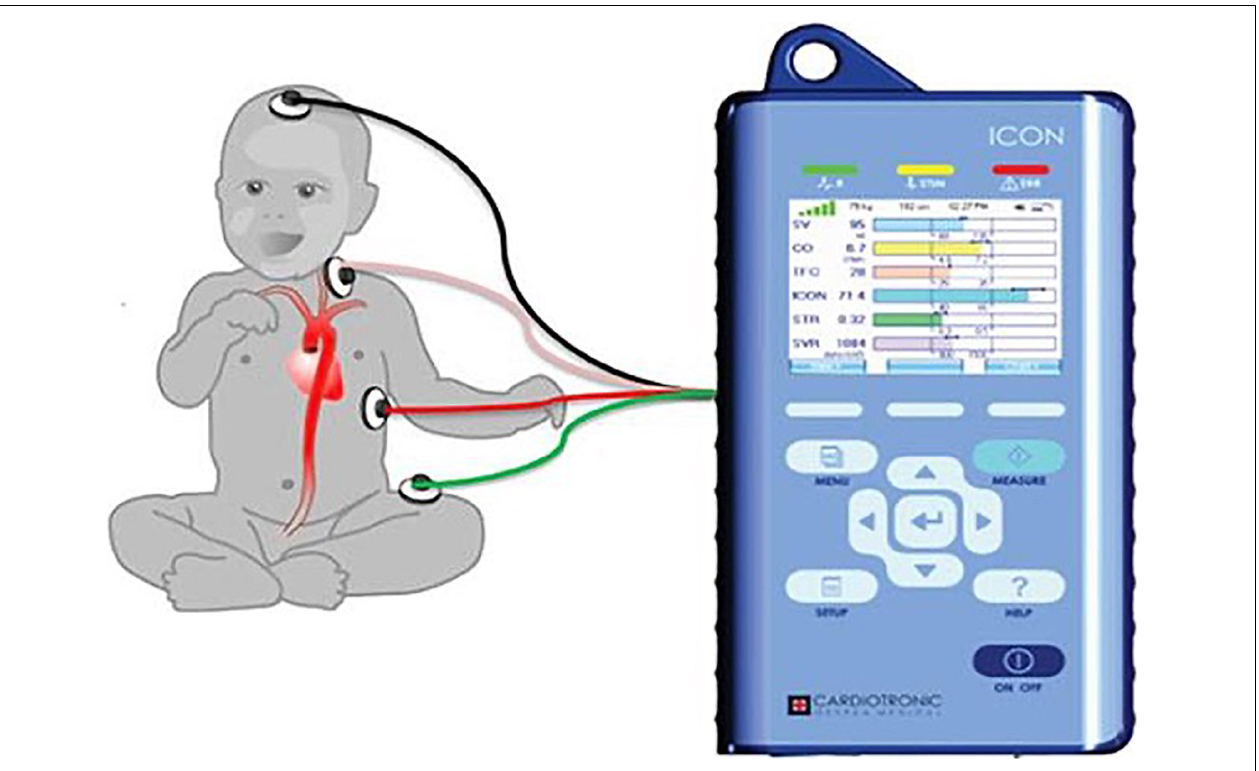
FIGURE 1 | The figure shows placement of ICON four sensors. One sensor placed on forehead, second sensor placed on left base of neck, third sensor placed on left thorax at the level of xiphoid, and fourth sensor placed on left thigh. Adopted from ICON user manual with due permission from Markus Osypka, Osypka Medical Inc.,